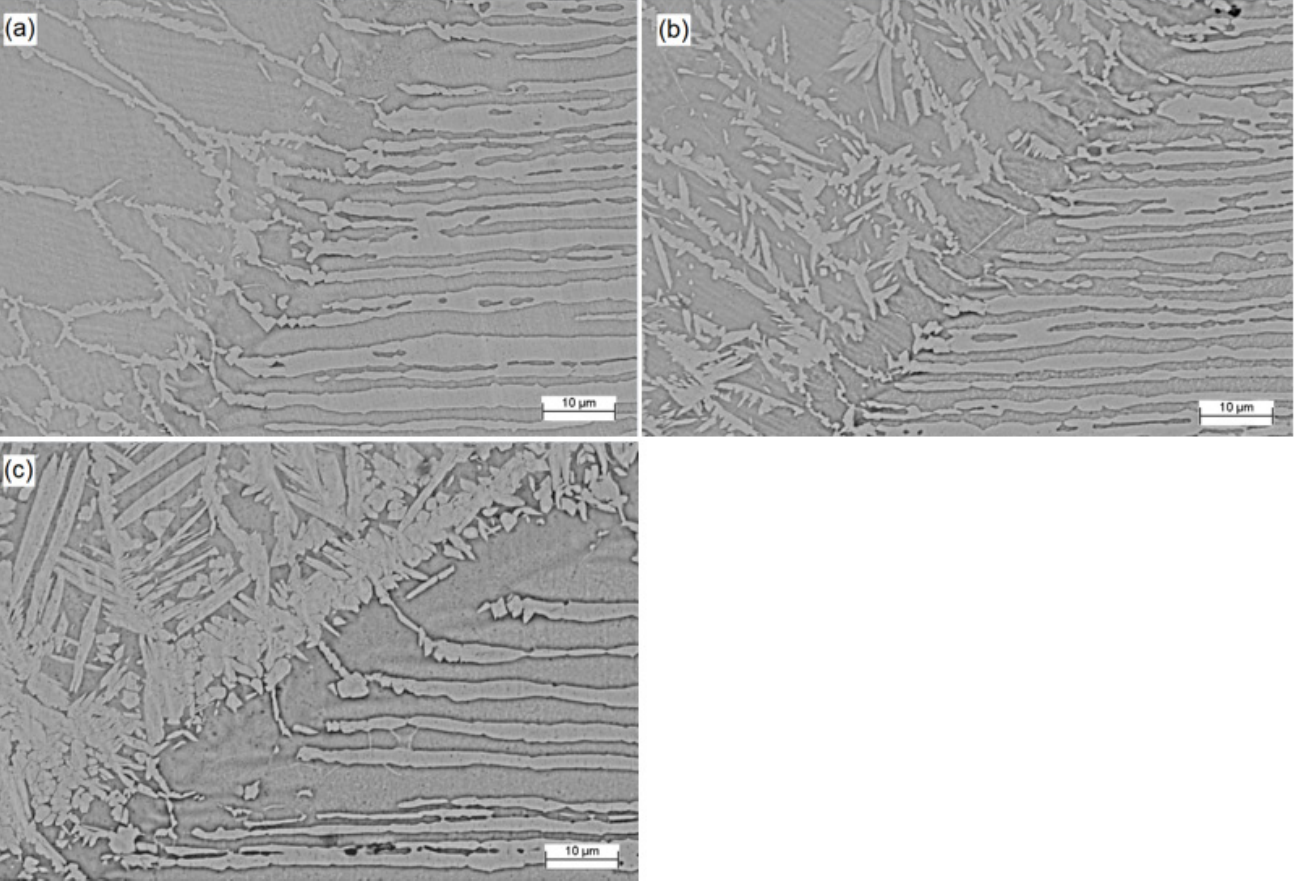
Figure 6. SEM micrographs of transitions for ( a ) Co12, ( b ) Co20 and ( c ) Co35. Table 3. Volume fractions for all the conditions.